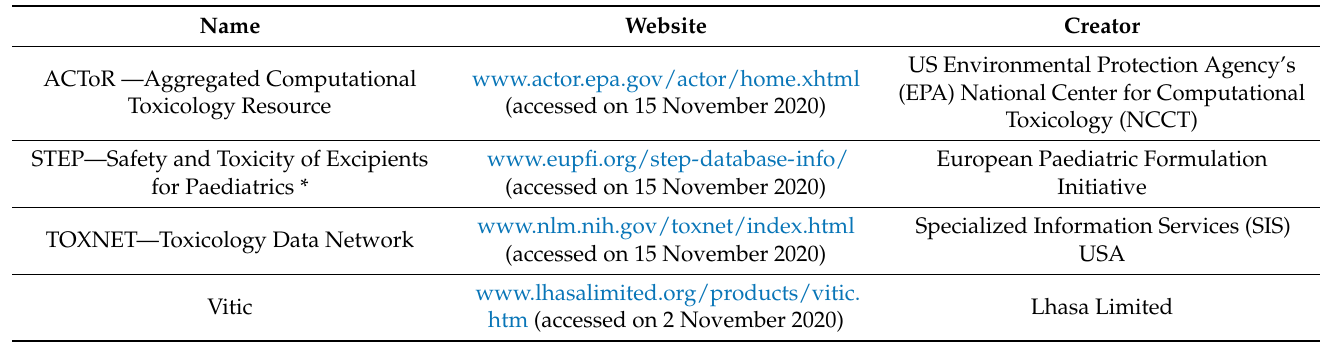
Table A5. Examples of liquid formulations for paediatric use in research articles. Table 1. Toxicity databases and public